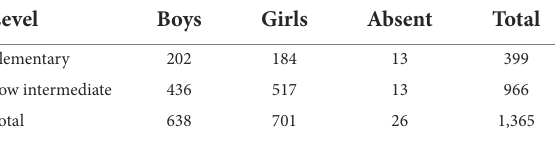
TABLE 1 Sample characteristics according to students’ EFL